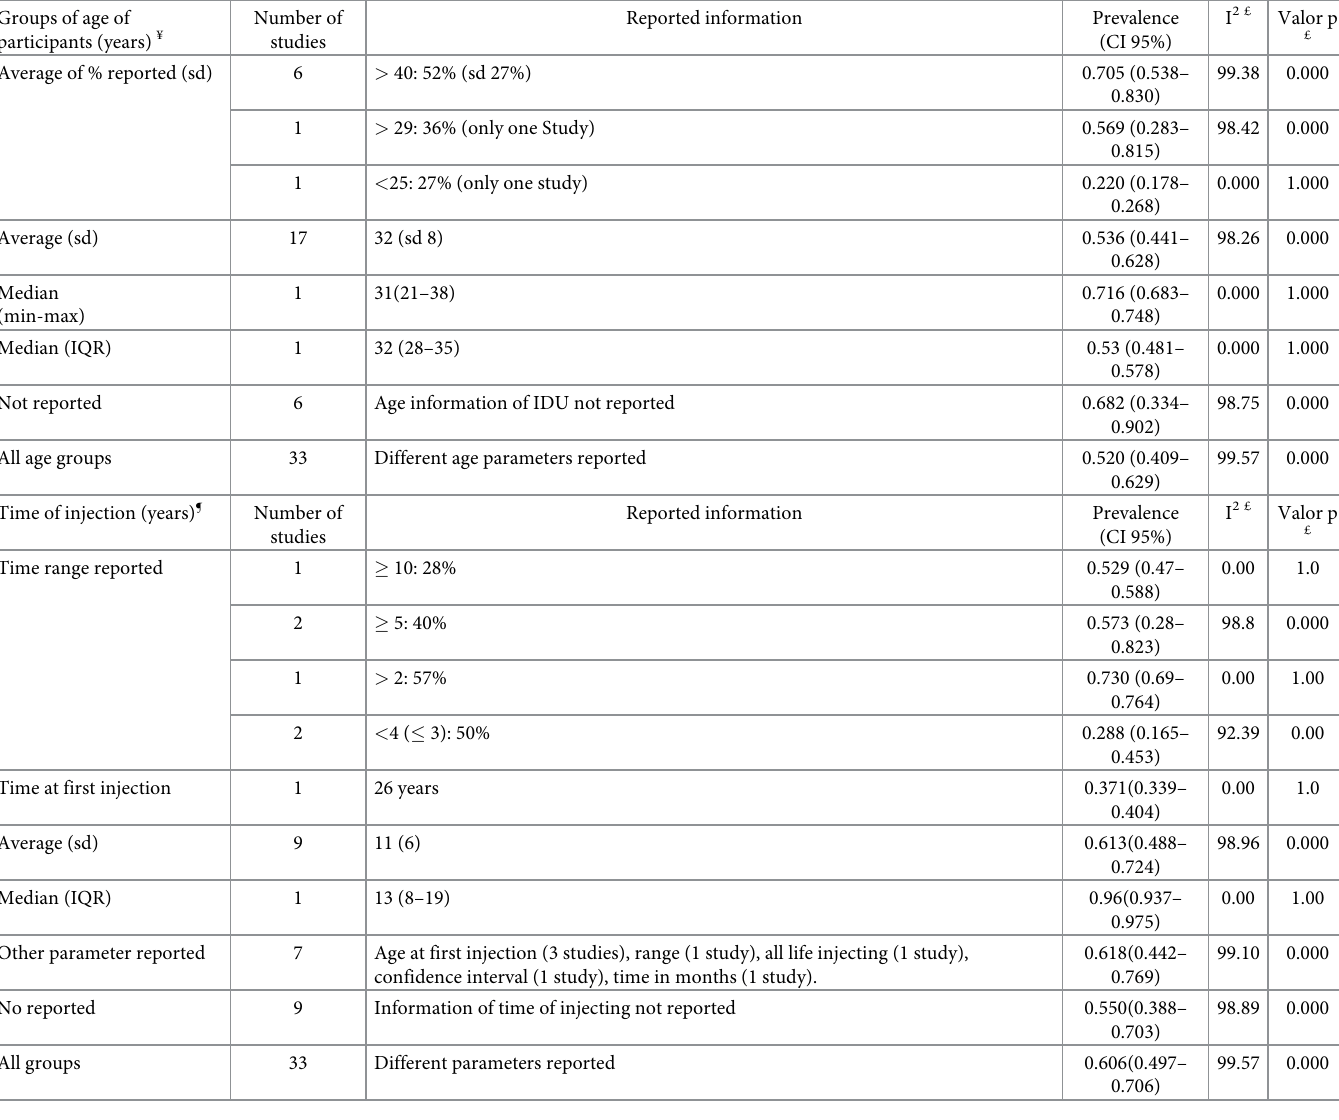
Table 3. Results of meta-analysis. HCV prevalence by age and duration of IDU reported in 33 studies. Groups of age of participants (years)